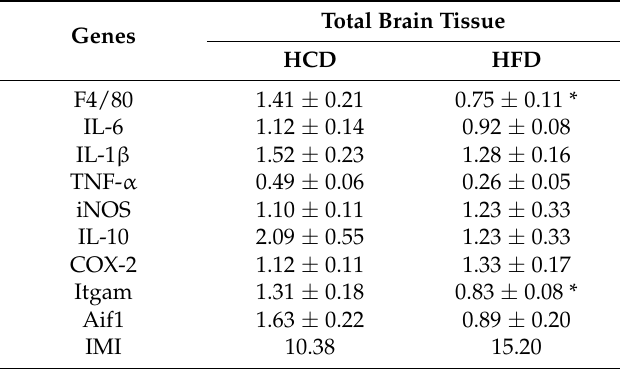
Table 3. mRNA expressions (arbitrary units) of inflammatory genes in the brains of mice fed with either high carbohydrate diet (HCD group) or high fat diet (HFD group) for 56